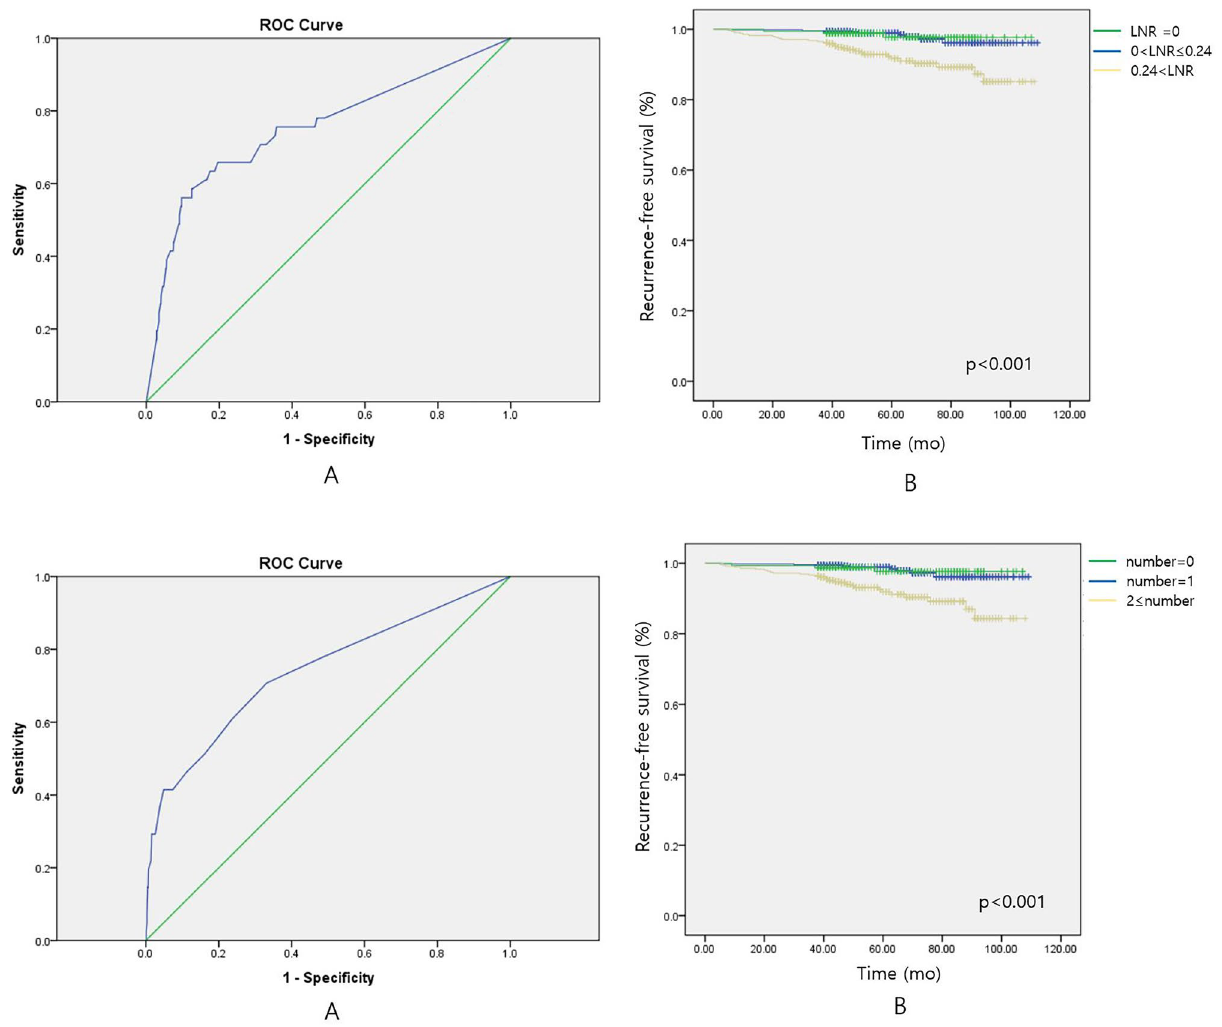
Figure 1. ( A ) The cut-off value for the lymph node ratio (LNR) was determined in consideration of the sensitivity and specificity optimized to predict disease recurrence using a receiver operating characteristic curve (ROC). Recurrence-free survival of the patient group with LNR > 0.24 was significantly decreased. ( B ) The cut-off value for the number of metastatic LNs was determined in consideration of the sensitivity and specificity optimized to predict disease recurrence using a ROC. The recurrence-free survival of the patient group with two or more metastatic LNs was significantly decreased. (The graph was made by statistical software SPSS version 25.0 for windows).